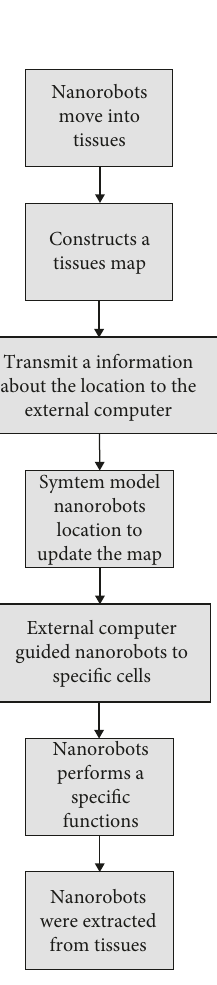
Figure 4: Flowchart for nanorobots into tissues execution